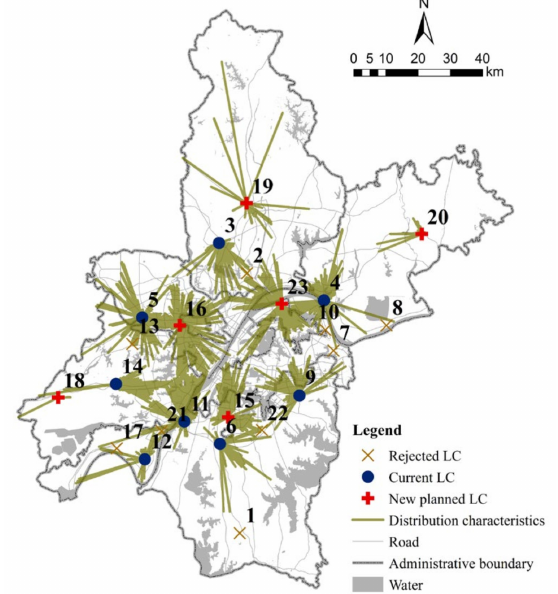
Figure 12. Site location and allocation results by the P-center